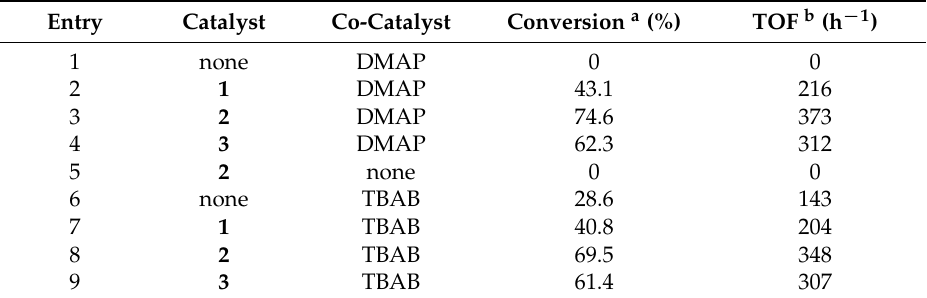
Table 3. Conversion and turnover frequency (TOF) of various catalysts in the cycloaddition of CO 2 to propylene oxide